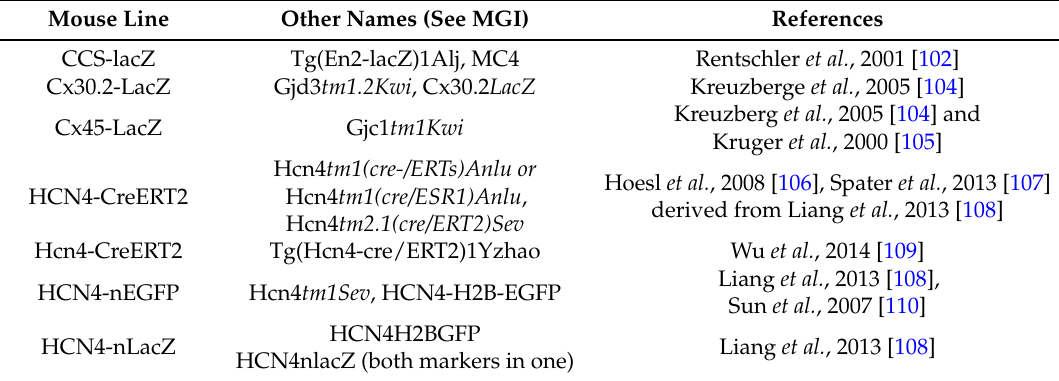
Table 1. Mouse lines for the study of the developing pacemaking and cardiac conduction system. Mouse